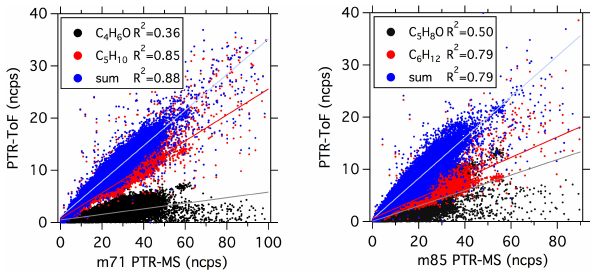
Figure 8. PTR-QMS and PTR-TOF intercomparison for mass 71 and mass 85 during